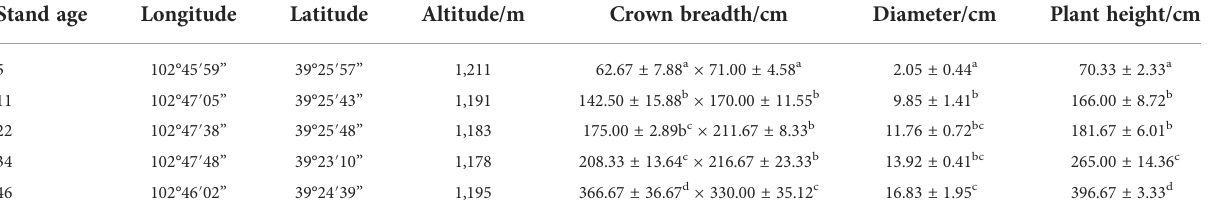
TABLE 1 The growth index of Haloxylon ammodendron with different stand ages. Stand